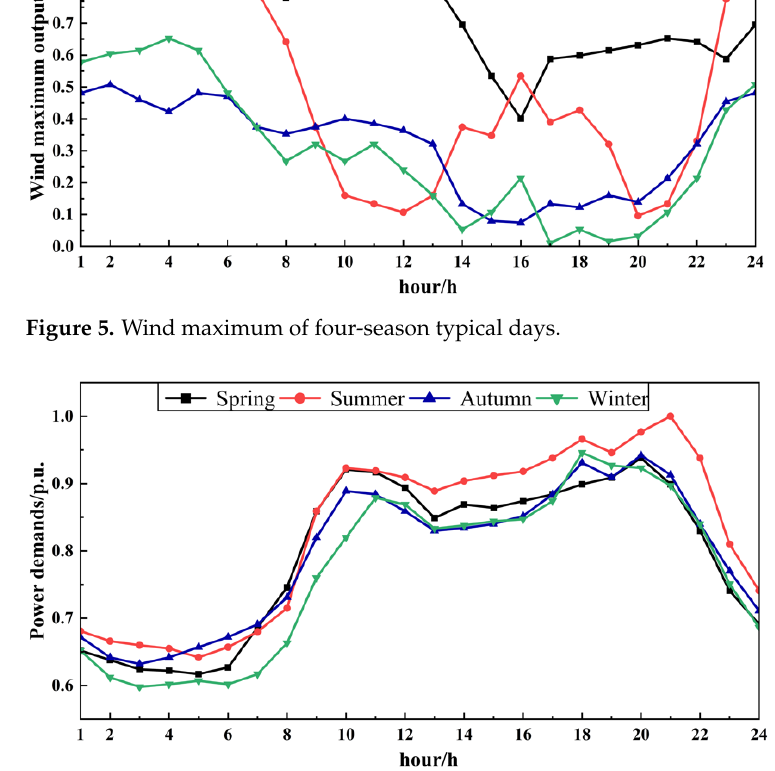
Figure 6. Power demand of four-season typical days.